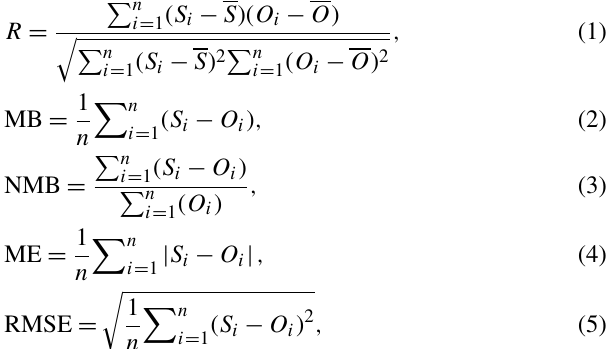
Observation instrument